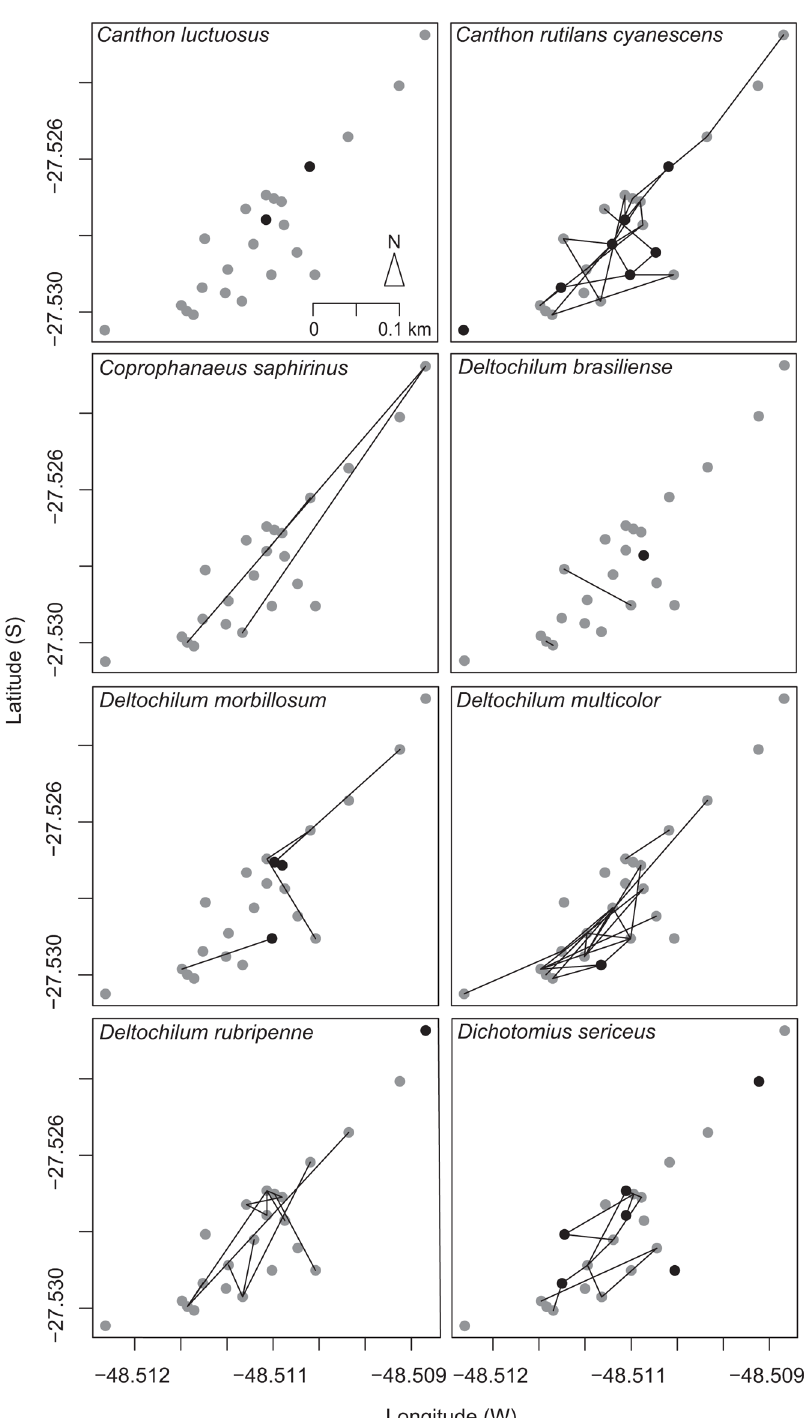
Fig 1. Movement patterns of dung beetle species. Circles depict the trap design. Black circles depict recaptures of individuals in the same trap. Each line segment depicts a dung beetle movement between two traps. Time between recaptures ranged from 5 – 87